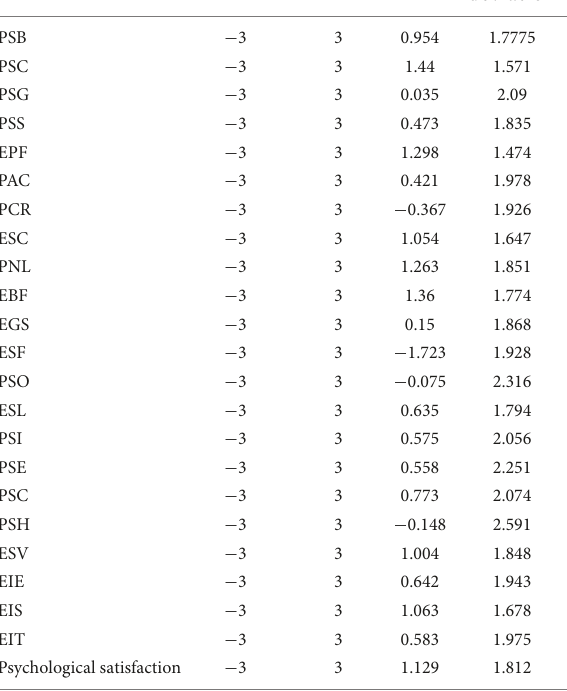
TABLE 2 Descriptive statistics.